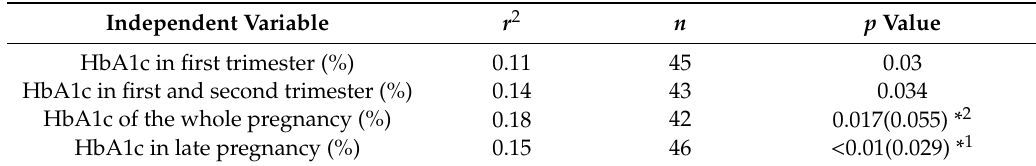
Table 2. Results of regression analysis of HbA1c during pregnancy in relation to the dependent variable vitC in late pregnancy in our study cohort.